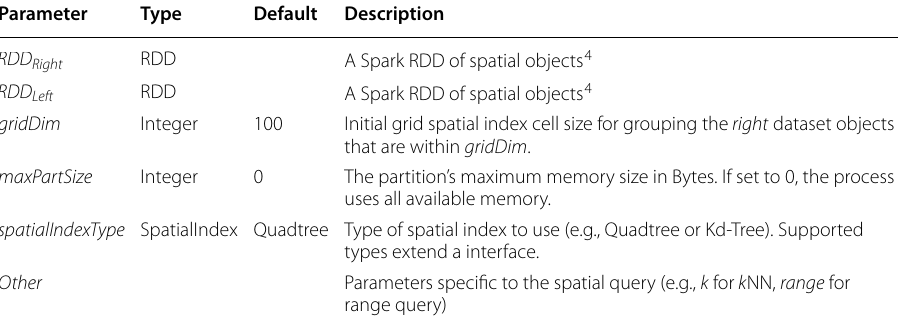
Table 2 Required and optional input parameters Parameter Type Default Description RDD Right